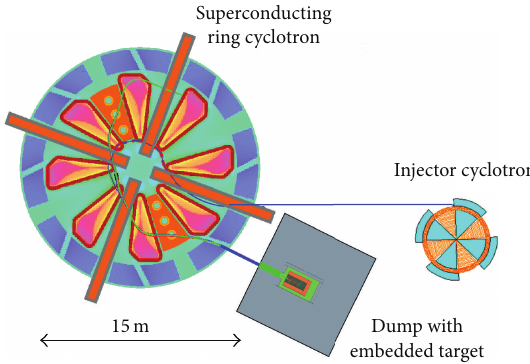
Figure 6: A DAE 𝛿 ALUS